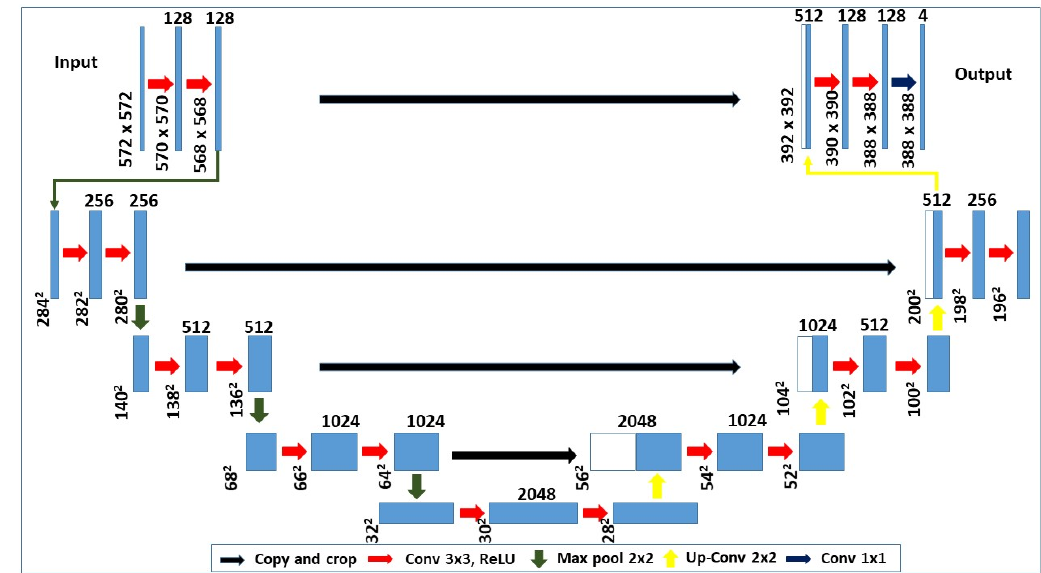
Figure 5. The U-Net architecture used for crack